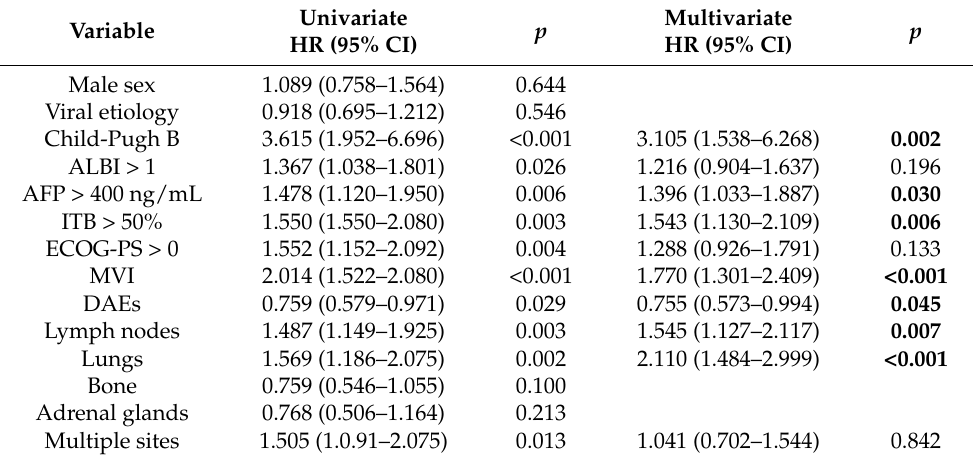
Table 3. Univariate and multivariate Cox regression analysis of overall